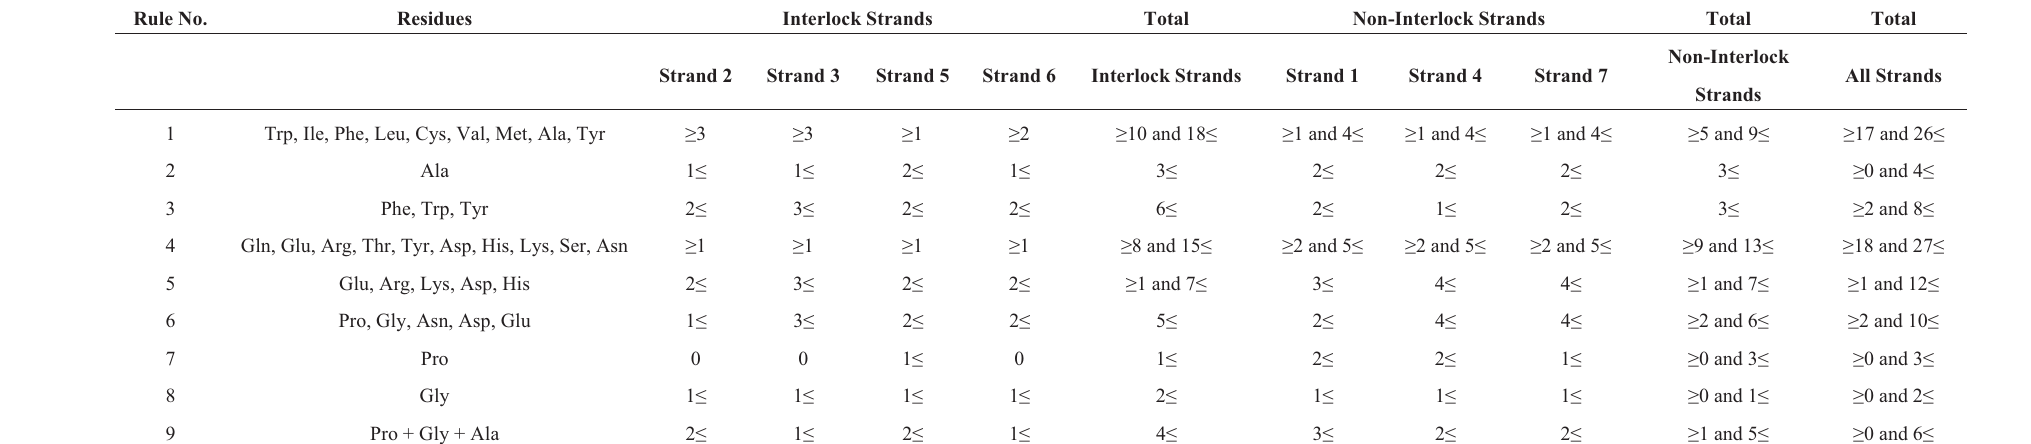
Table 3. The rules of assignment of residues at any position in strands.